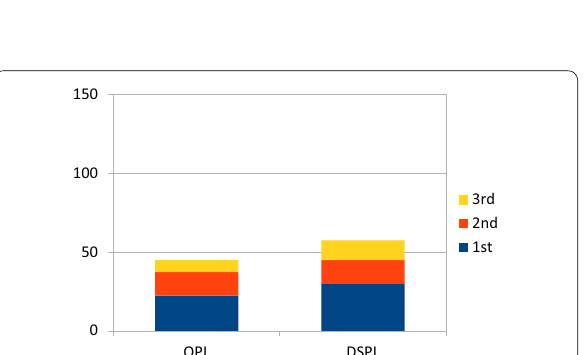
Fig. 26 Total points of top three teams for Storing Groceries in 2017 (Obtained from [48])